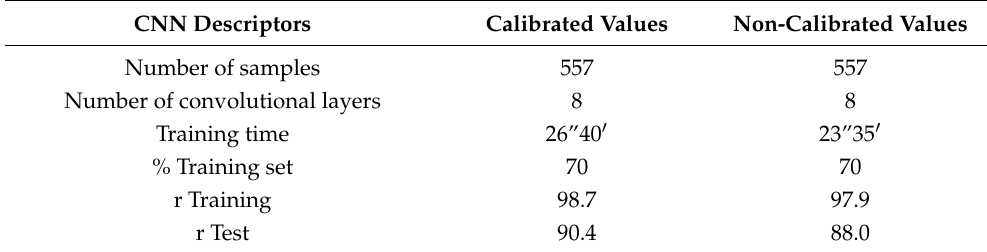
Table 4. Results of the CNN model for calibrated and non-calibrated